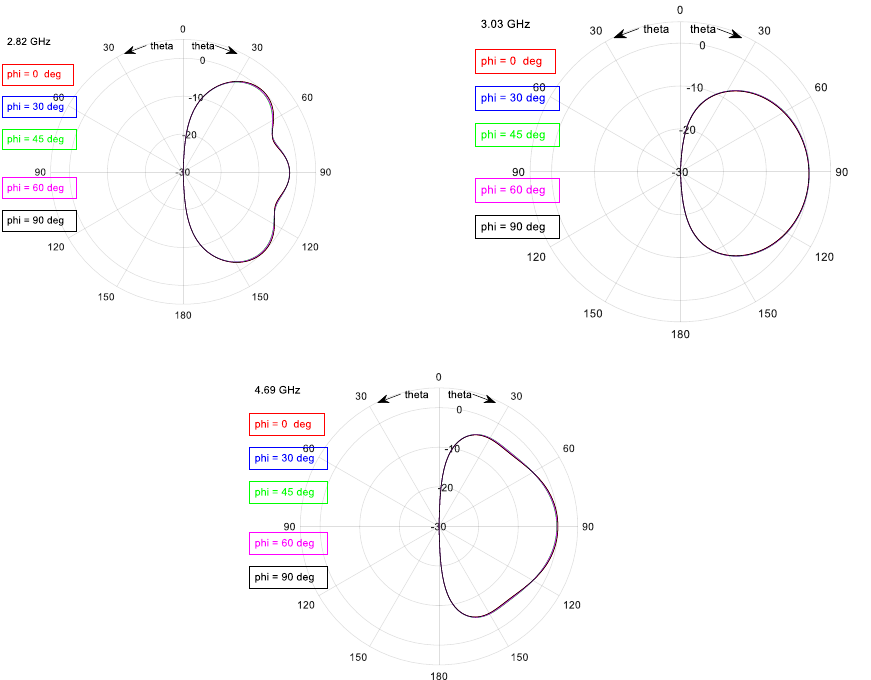
Figure 19. The radiation patterns of the 12-ring-loaded MBA at middle-frequency points of five bands with VSWR ≤ 2 in Table 1.